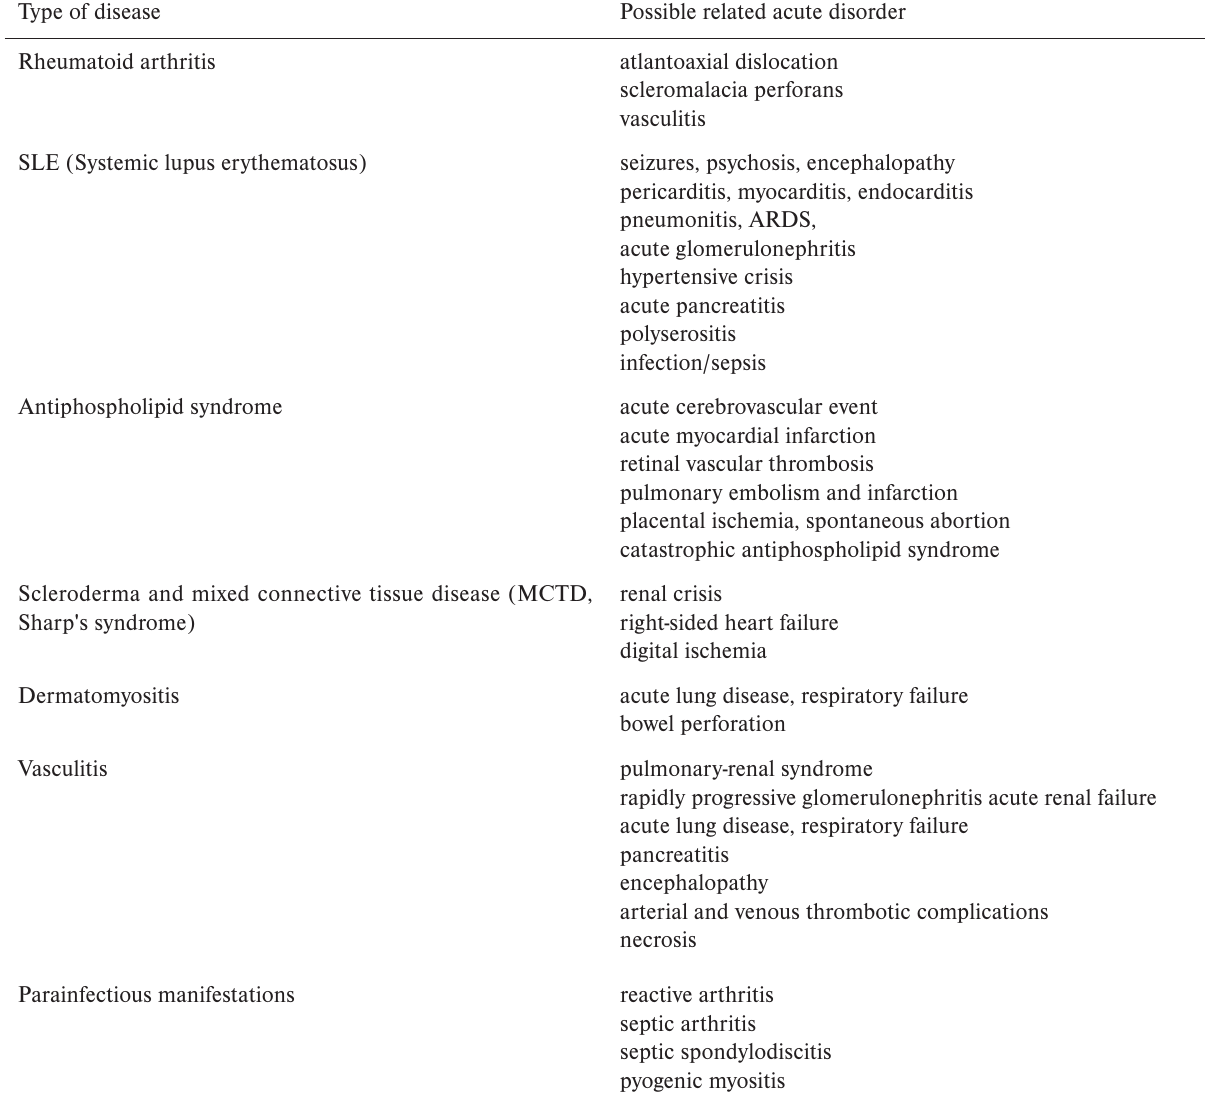
Table 1. Acute disorders in systemic rheumatic